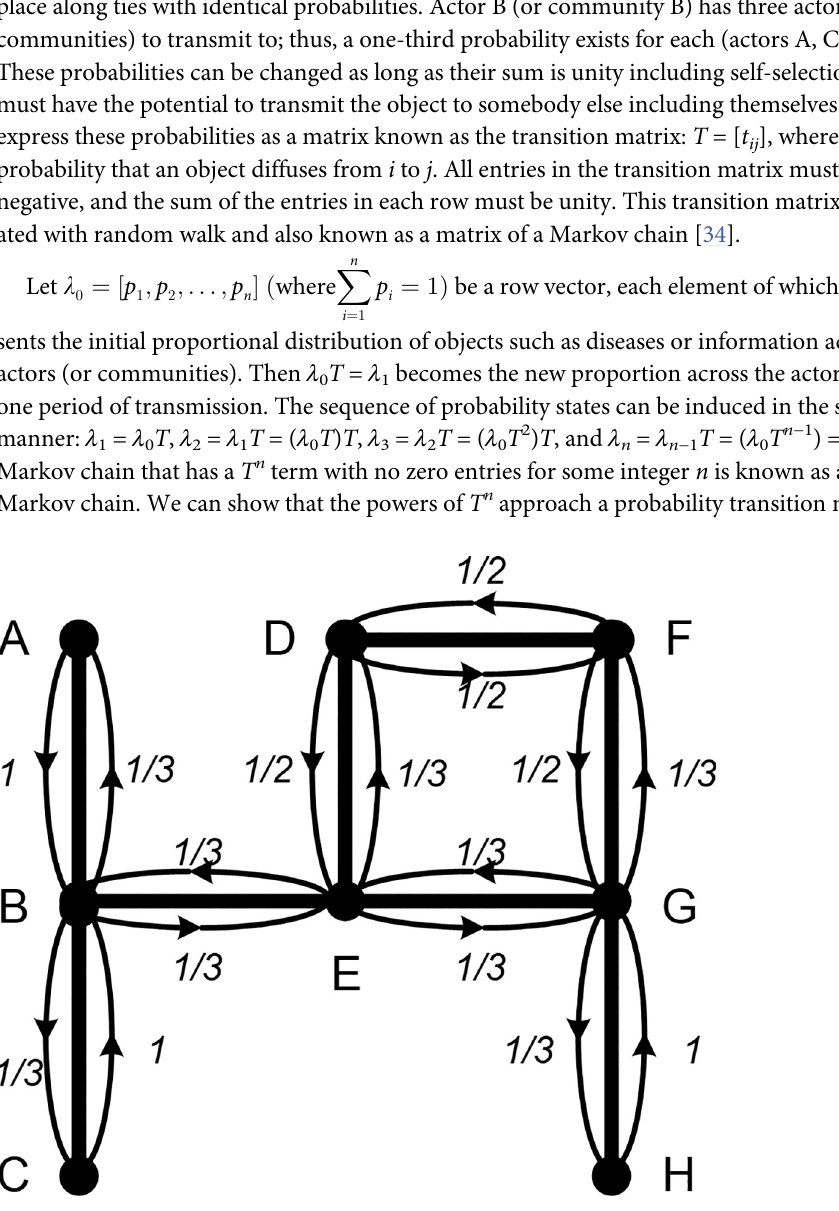
Fig 2. Hypothetical network indicating the transition